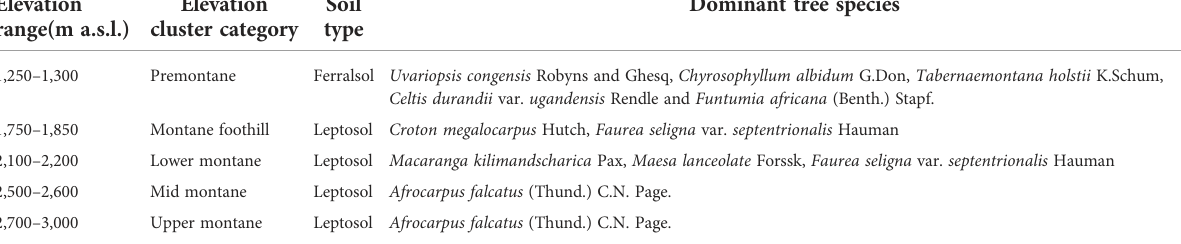
TABLE 1 Elevation clusters for the studied plots in the east-facing slope of Rwenzori mountains, extending to Kibale Forest National Park, ranging from premontane forest to upper montane forest with major soil type and dominant tree species. Elevation range(m